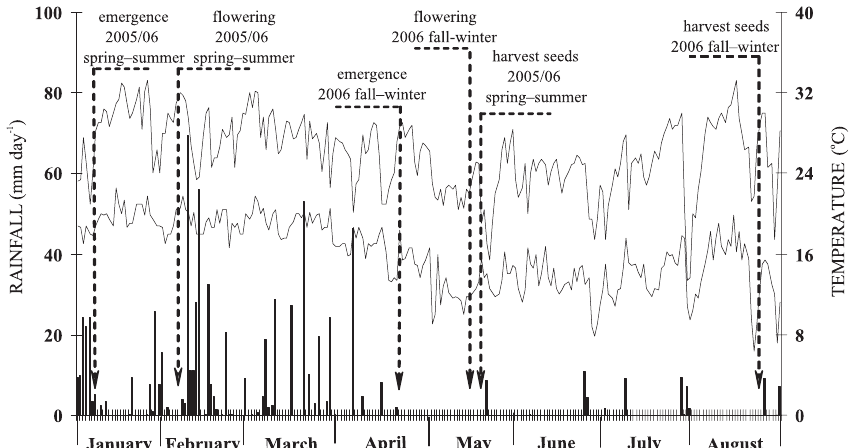
Figure 1. rainfall ( ) and maximum ( ) and minimum ( ) temperatures recorded during the experi- ment, and timeline of emergence, flowering and harvest of castor bean hybrid Lyra in the 2005/2006 spring-summer and 2006 fall-winter growing